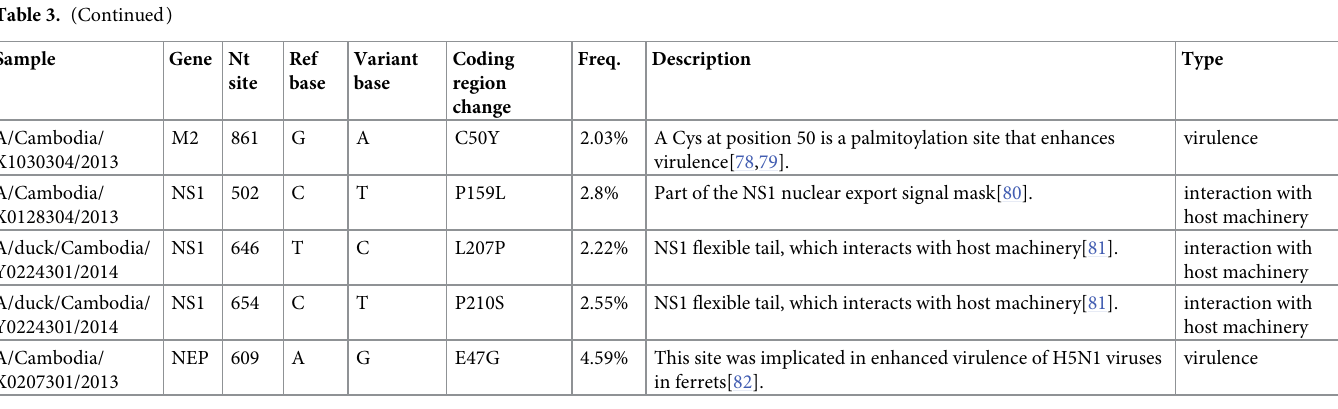
All nonsynonymous mutations that were identified in sites with putative links to host-specific phenotypes are shown. We identify a handful of amino acid mutations that have been explicitly linked to mammalian adaptation of avian influenza viruses. For HA mutations, all mutations use native H5 numbering, including the signal peptide. For ease of comparison, the corresponding amino acid number in mature, H5 peptide numbering is also provided in parentheses in the description column. Full annotations for all mutations in our data are shown in S1 Table .